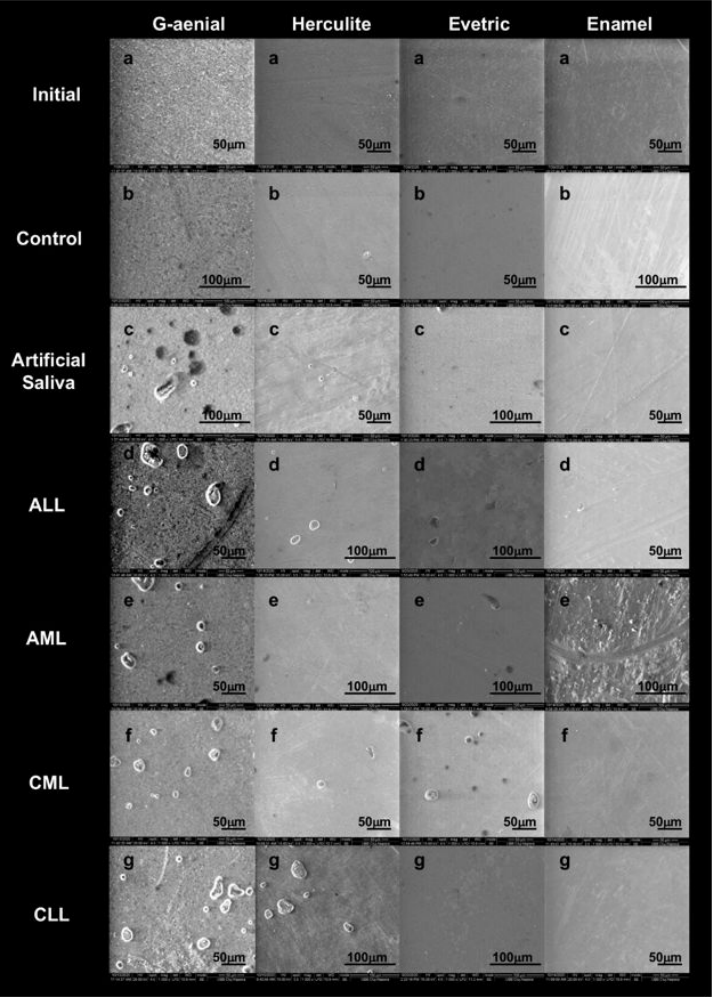
Figure 4. SEM images of RBCs: ( a ) initial (immediately after the polymerization process) and after 7 days of immersion in various saliva: ( b ) control; ( c ) artificial saliva; ( d ) ALL; ( e ) AML; ( f ) CLL; ( g ) CML (1000 ×